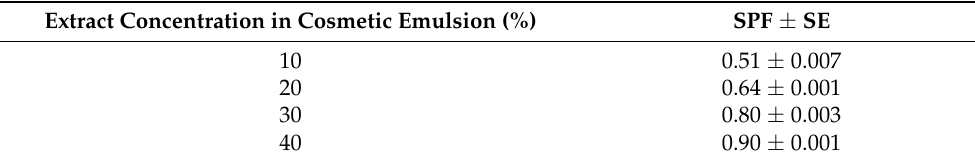
Table 3. SPF ± SE values obtained for cosmetic creams with concentrated plant